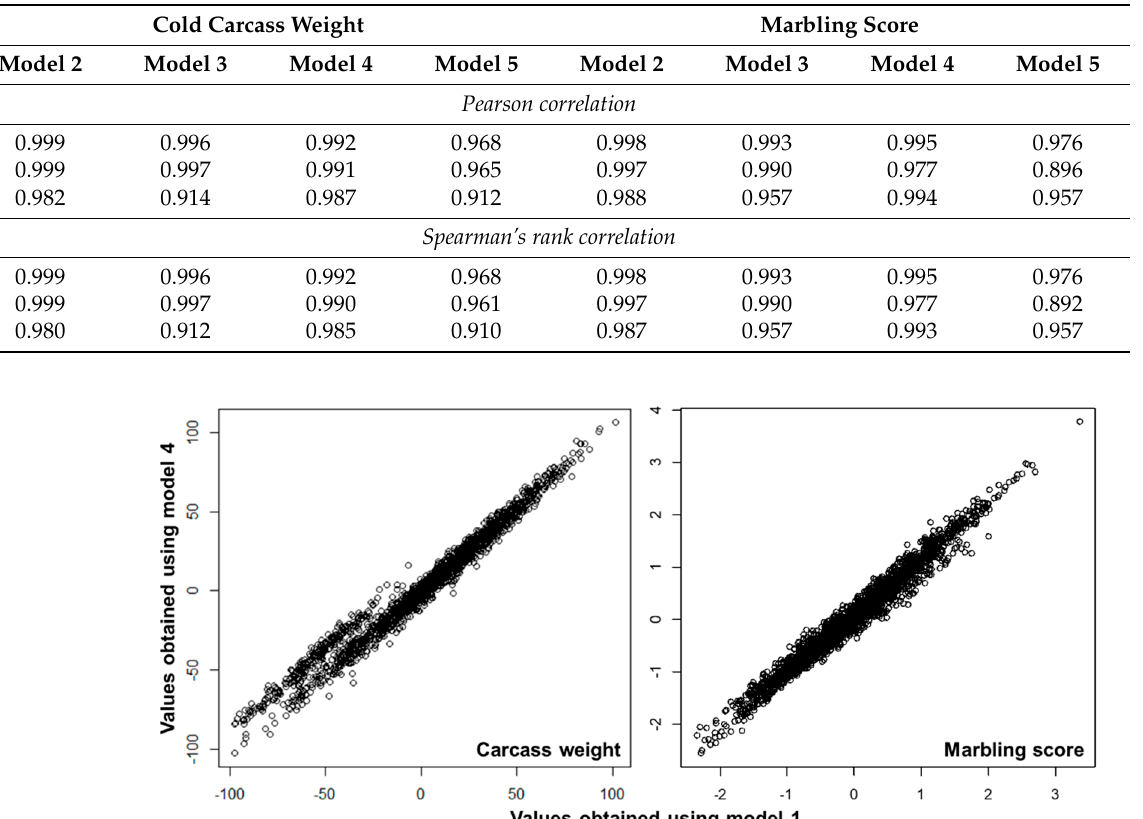
Table 4. Pearson and Spearman’s rank correlations of predicted genomic breeding values obtained using model 1 and those obtained using other 4 models for the steers marketed into Tottori, Hiroshima, and Hyogo prefectures.